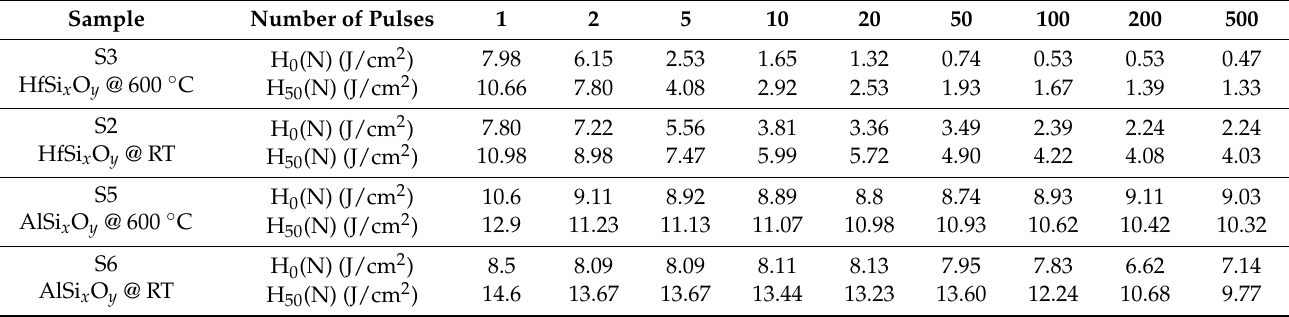
Table 4. Hafnium silicate and aluminium silicate LIDT test